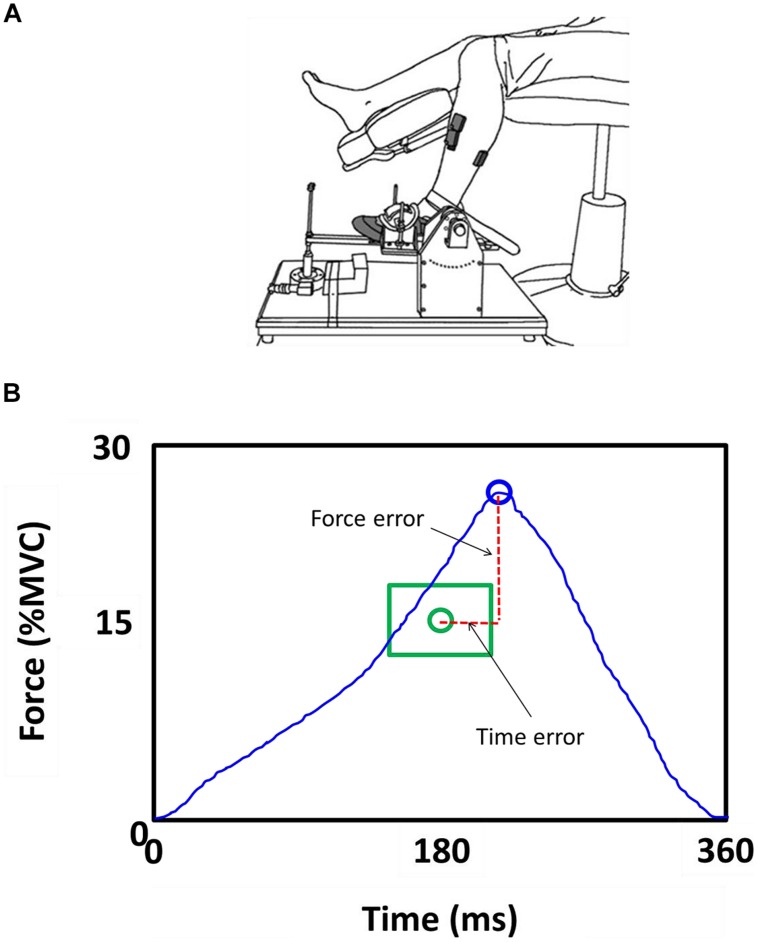
Goal-directed task. (A) Subjects were seated with the hip, knee, and ankle joint at 90°. The left foot was restrained in an ankle device. Subjects performed a goal-directed ankle dorsiflexion contraction with the left foot. (B) Force and time-to peak force errors were normalized to the targeted force and time.